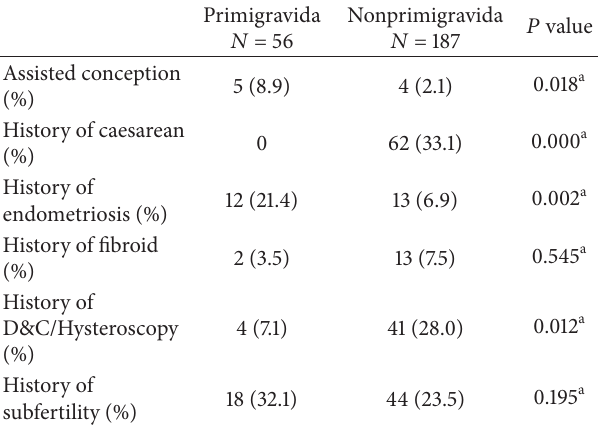
Table 2: Factors associated with major placenta